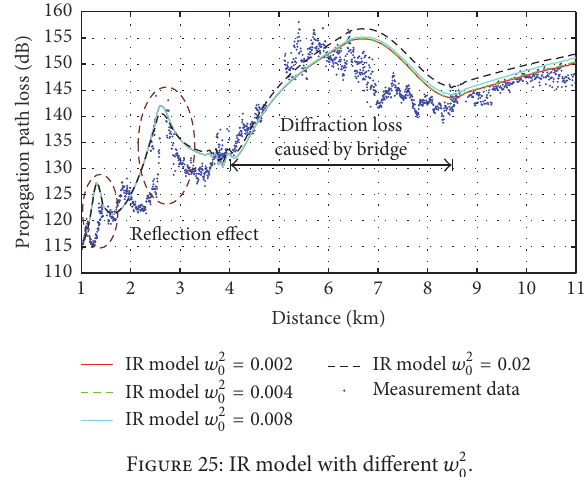
Figure 25: IR model with different 𝑤 2 0